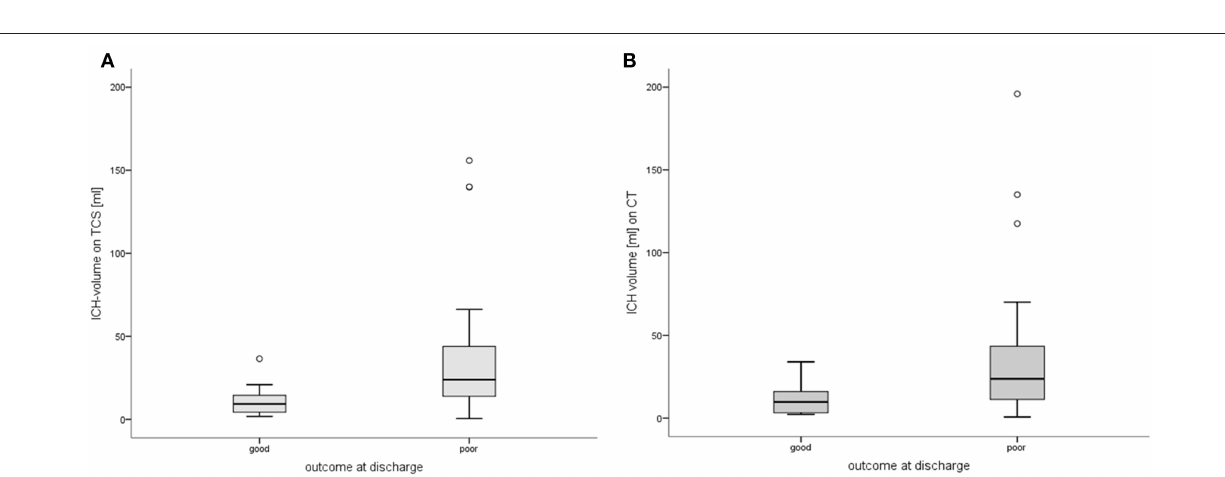
Frontiers in Neurology |